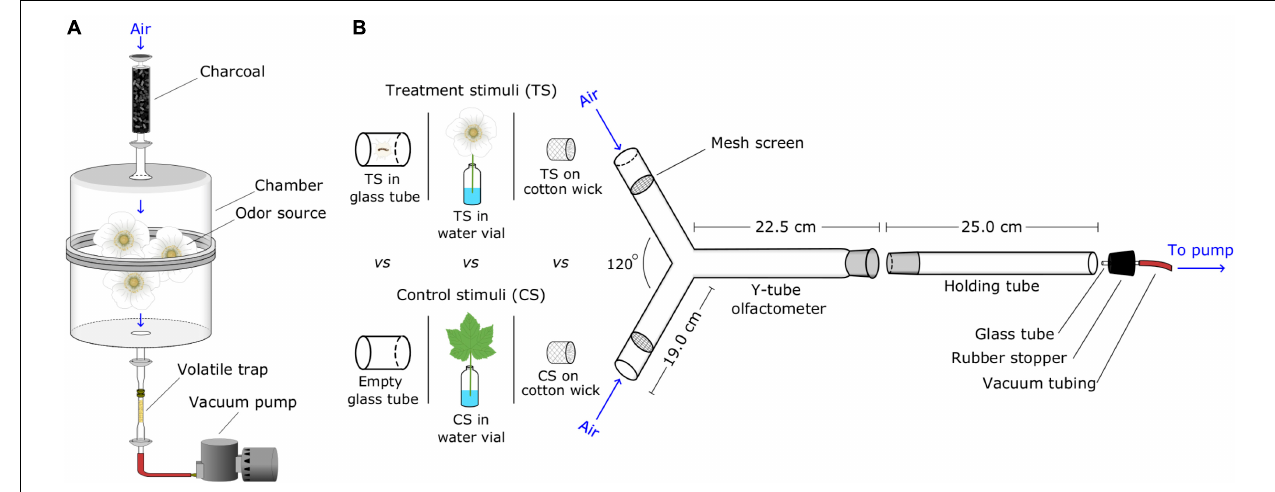
FIGURE 1 | Graphical illustrations of experimental designs. (A) Set-up for collecting headspace volatiles from natural sources; air was drawn through activated charcoal, a glass chamber containing a natural odor source, and a volatile trap (the adsorbent Porapak in a glass tube). (B) Y-tube olfactometer bioassay station for testing attraction of ants to test stimuli; for each replicate, test stimuli were ( i ) placed in small plastic bags secured to the side arms of the Y-tube, or ( ii ) inserted directly into the side arms. Then, the holding tube housing a single bioassay ant was connected to both a vacuum pump and the Y-tube, allowing the ant to walk upwind toward test stimuli. Test stimuli consisted of natural odor sources, headspace volatile extracts (HVEs), and synthetic blends (SBs) of candidate semiochemicals. Aliquots of HVEs, SBs and corresponding solvent control stimuli were pipetted onto pieces of cotton wick placed at the orifice of side arms (see Table 1 for